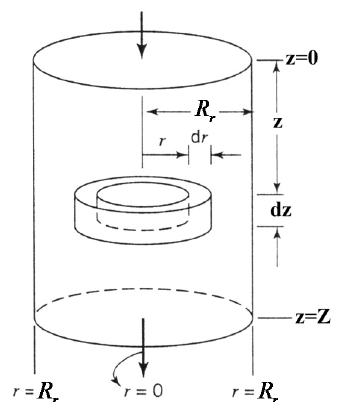
Figure 11. Scheme of the coordinate system and control volume for the fixed-bed conservation equations. Figure11.